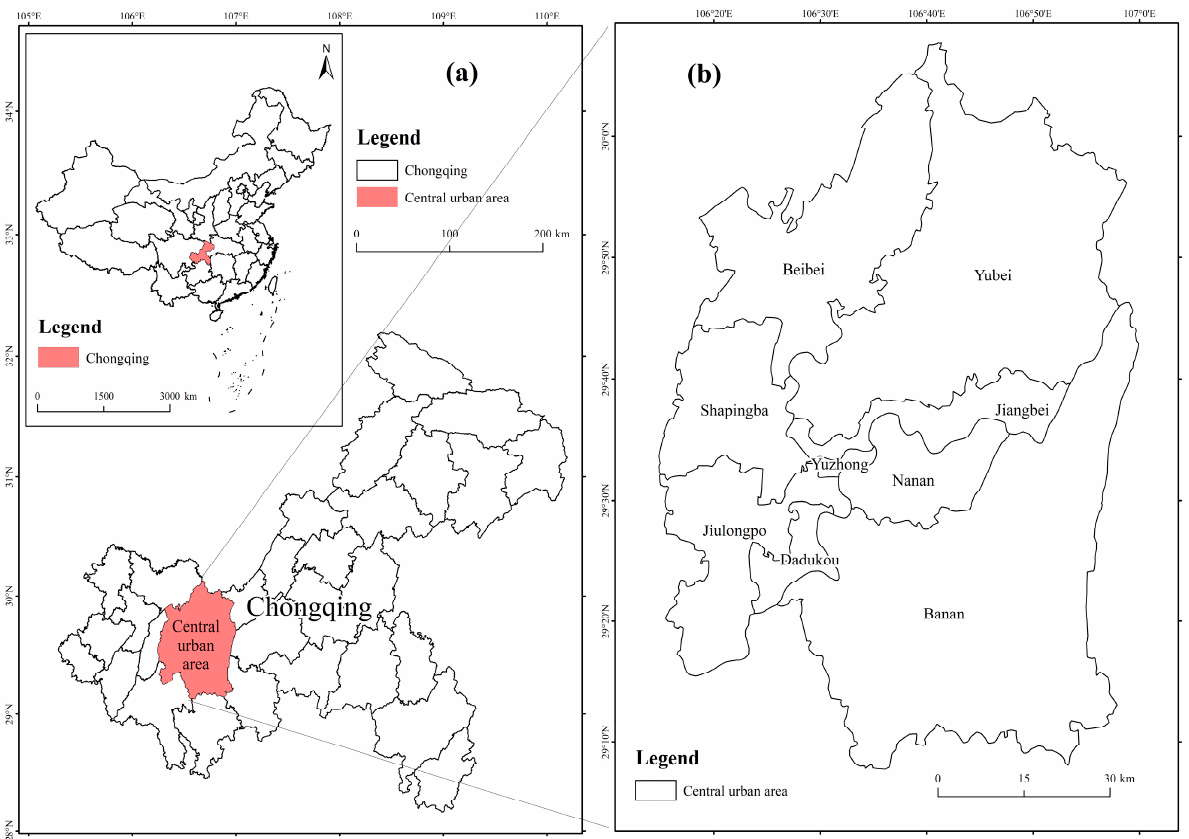
Figure 1. The study area: ( a ) the location of central urban area in Chongqing; ( b ) administrative division of the central urban area.